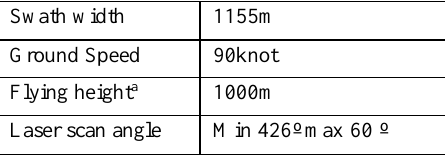
Table 1. Summary of discrete LiDAR returns and details